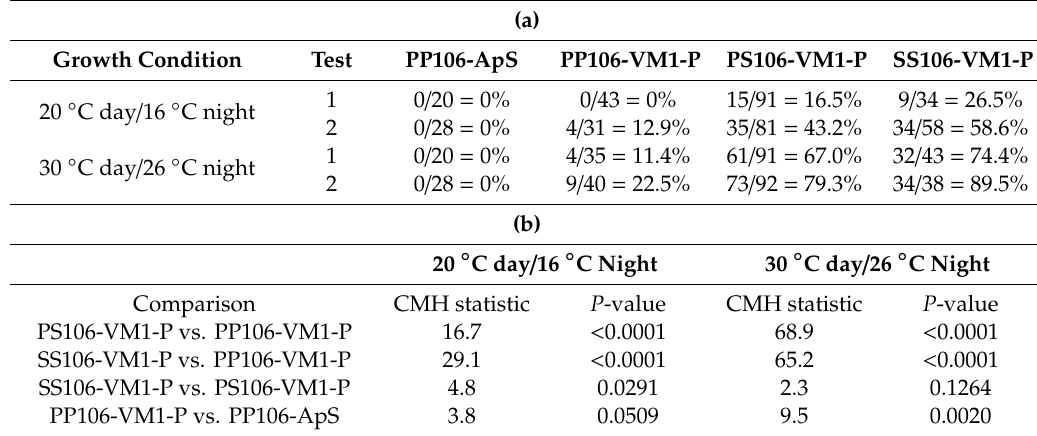
Table 4. ( a ) Survivorship and corresponding genotypic data at EPSPS codon 106 for glyphosate-treated ApS and VM1-P plants maintained at low and high temperatures. ( b ) Comparison between plant genotypes based on P -values from the Cochran–Mantel–Haenszel test.